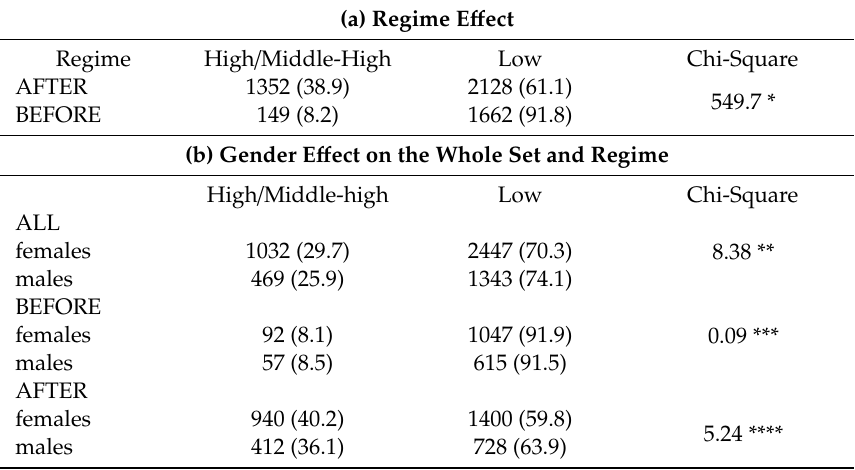
Table 4. Contingency table and relative inferential statistics for the regime and GENDER correlation (distribution across response clusters). The di ff erential distribution of the di ff erent subject categories into the response clusters confirms the analysis of variance approach (overwhelming importance of regime, gender di ff erence reaching statistical significance in the AFTER group). The percentages are inserted in